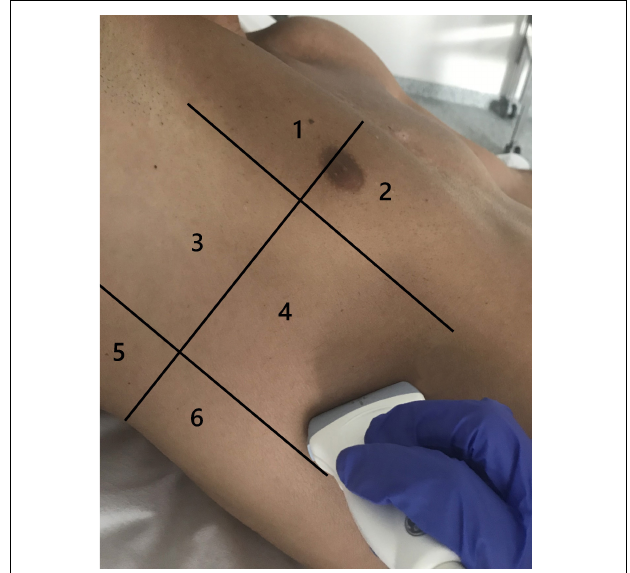
FIGURE 2 | Lung regions scanned in a 12-region LUS exam shown for one hemithorax. LUS images were acquired using a linear transducer and a transversal approach. Zones 1 and 2 are anterior LUS regions, zones 3 and 4 are lateral LUS regions, and zones 5 and 6 are posterior LUS regions. LUS, lung